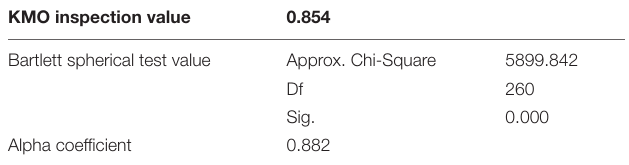
TABLE 4 | Reliability and validity